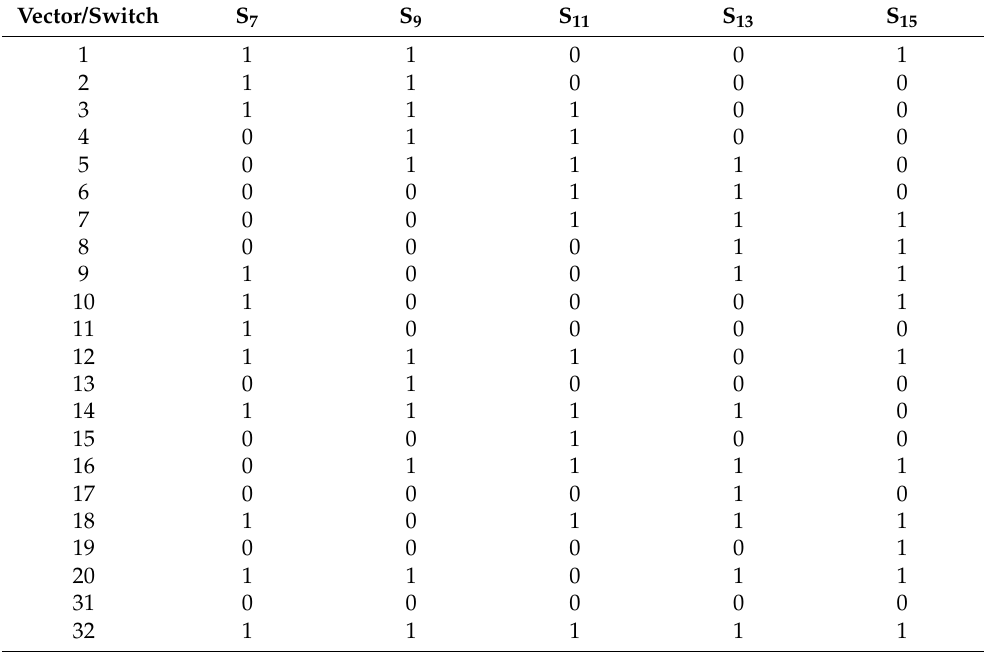
Table 4. Definition of the inverter